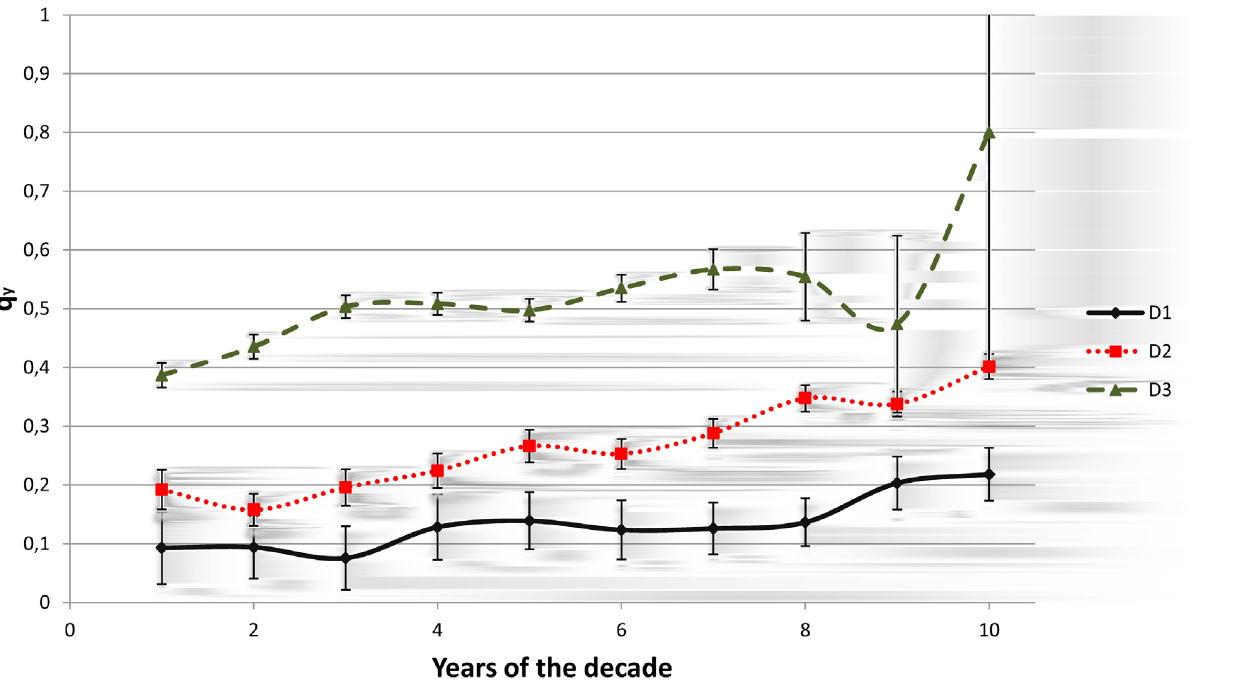
Fig 4. Proportion of A-A publications with regard to the total number of publications of the advisee ( q y ) for the Exact Sciences.